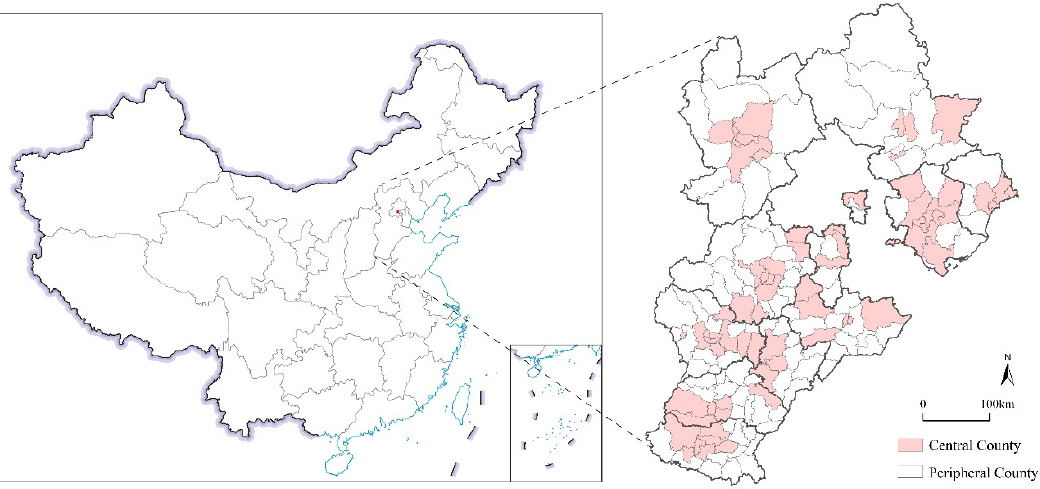
Figure 2. Study area.